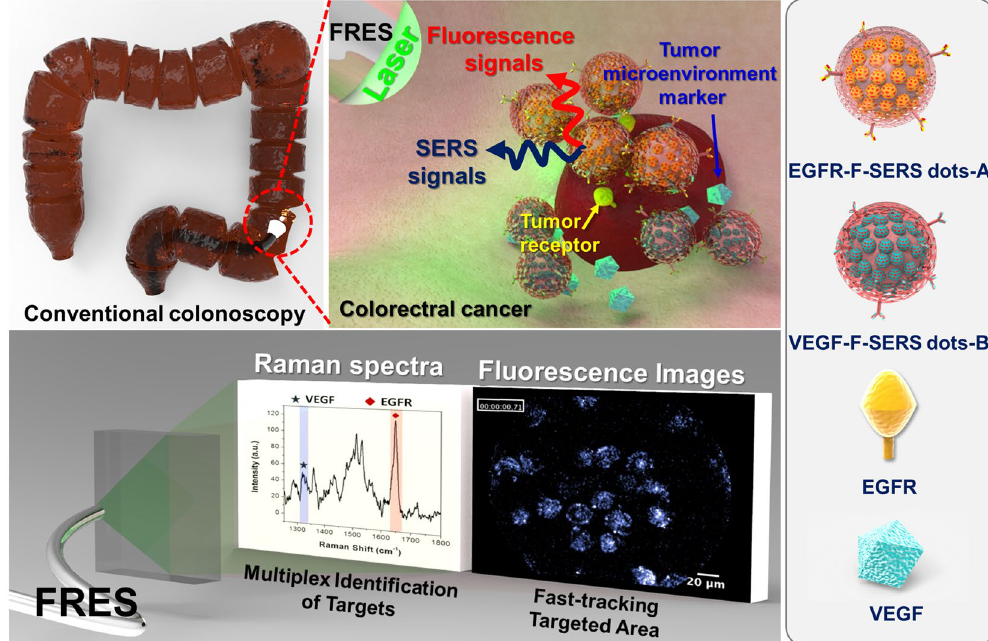
Figure 1. Schematic illustration of the in vivo multiplex molecular diagnosis on colorectal cancer using simultaneous fluorescence-Raman endoscopic system (FRES). FRES was able to detect fluorescence and Raman signals simultaneously for the molecular characterization of a tumor. When antibody-conjugated F-SERS dots were sprayed onto HT29-effluc colon cancer cells, the antibody-conjugated F-SERS dots bound to colon cancer cells [epidermal growth factor receptor (EGFR)] and tumor microenvironments [vascular endothelial growth factor (VEGF)]. FRES simultaneously utilizes the fluorescence signal of a fluorescent silica shell for fast signal detection [Alexa Fluor (AF) 610], and the Raman signals for multiplex targeting from the silver nanoparticles labeled by two kinds of Raman active compounds [rhodamine B isothiocyanate (RITC, -A) and fluorescein isothiocyanate (FITC,